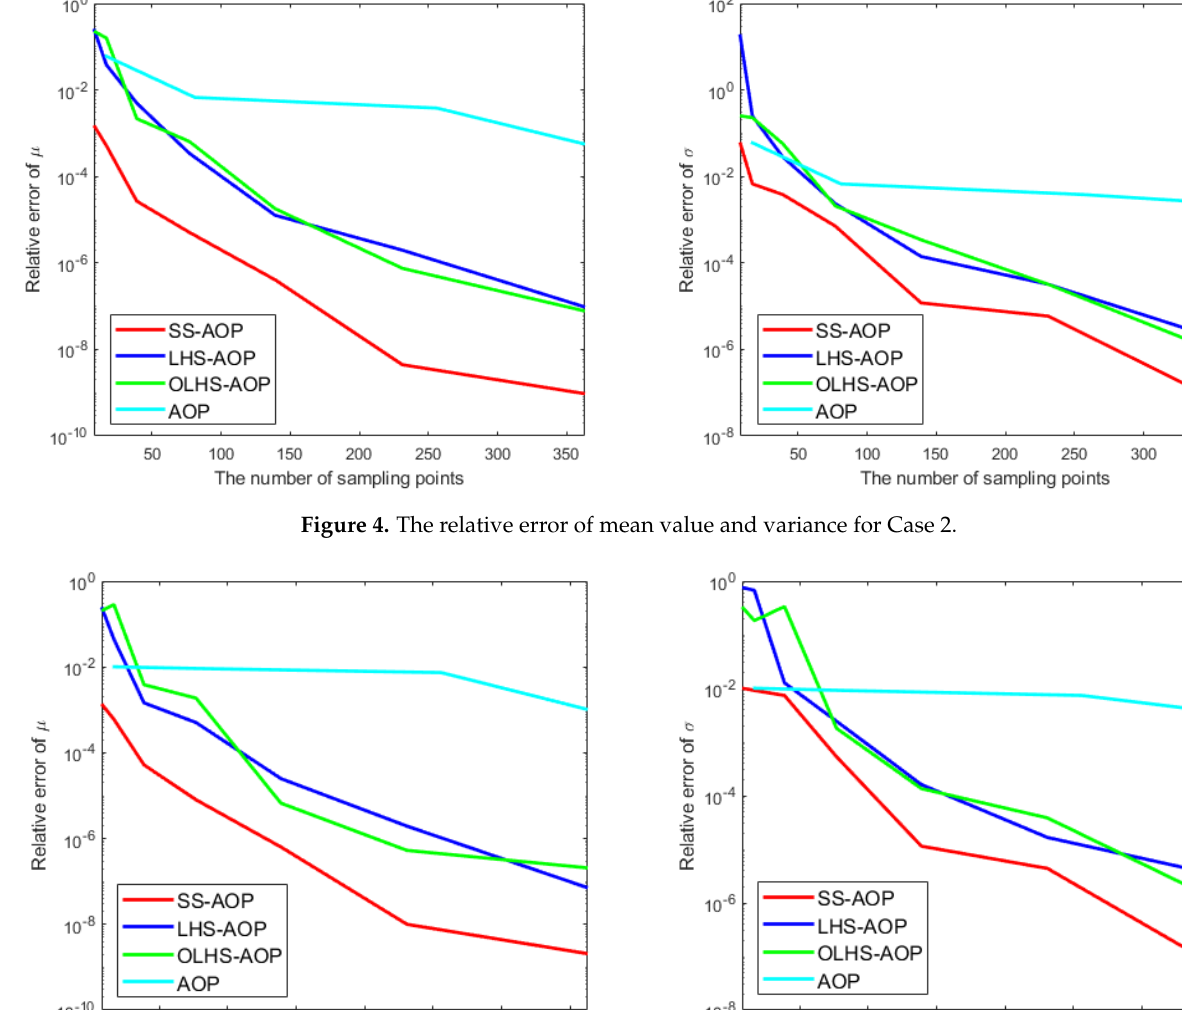
Figure 3. The relative error of mean value and variance for Case 1.